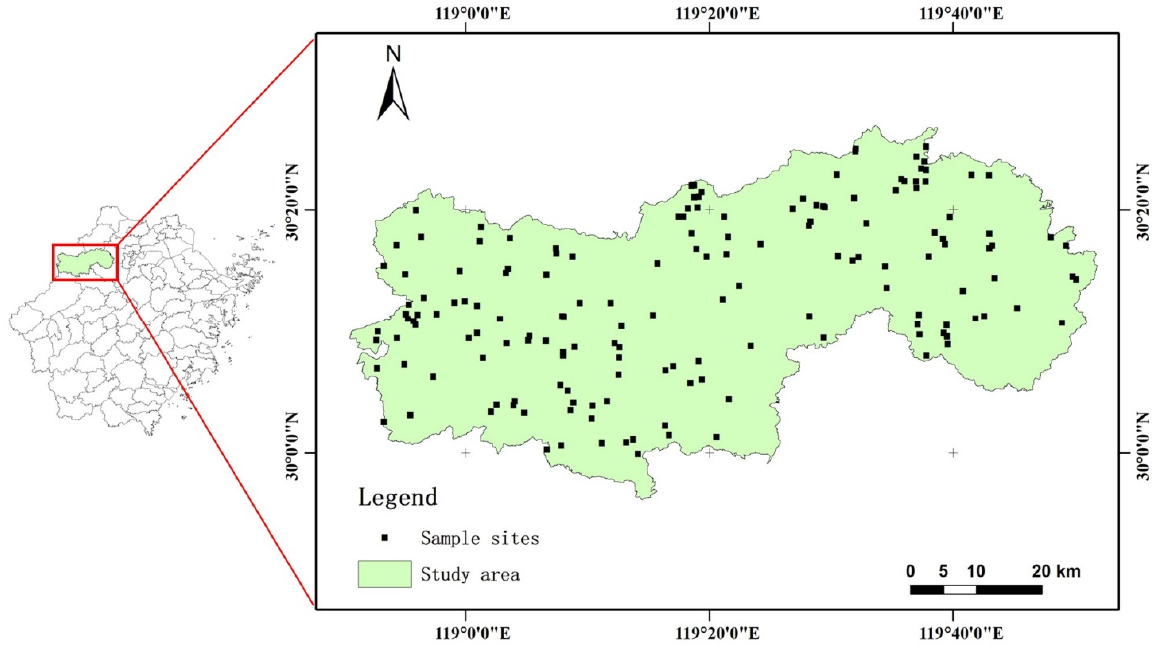
Figure 1. Spatial distribution of field sampling sites and location of study area in Zhejiang.